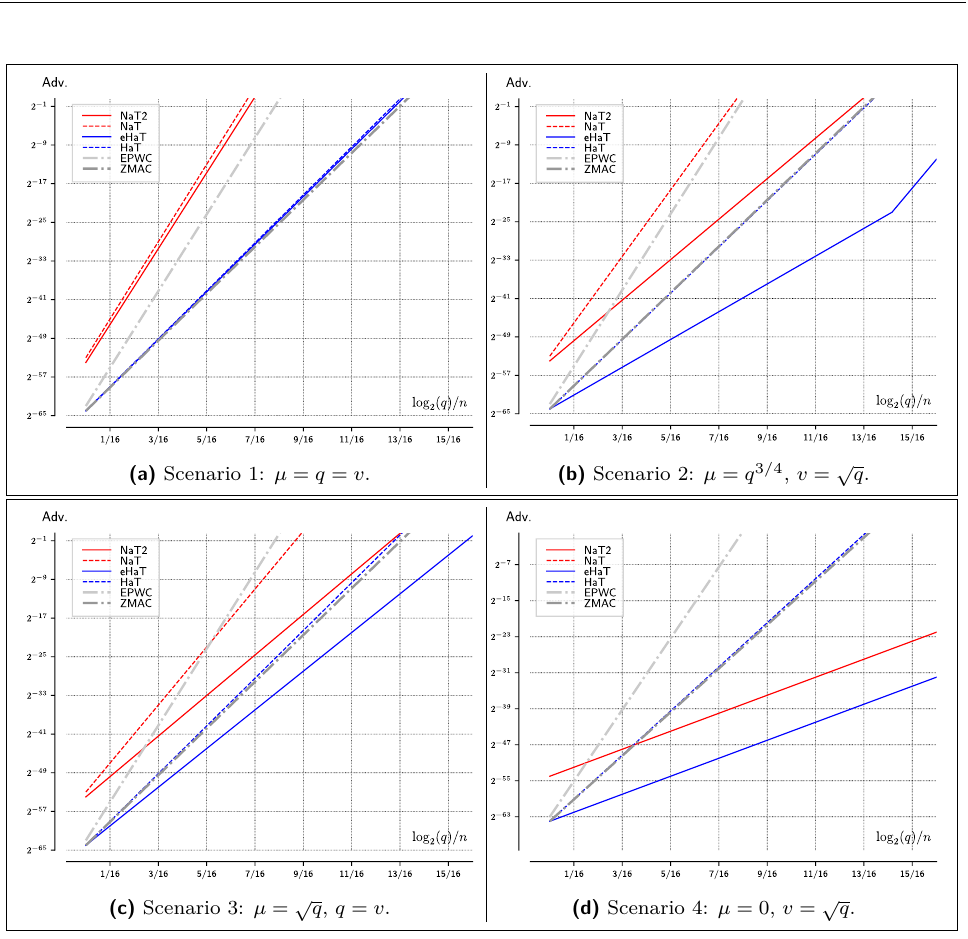
Figure 2: Security comparison of existing schemes with NaT2 and eHaT in four scenarios with different number of repeating-nonce queries µ and verification queries v